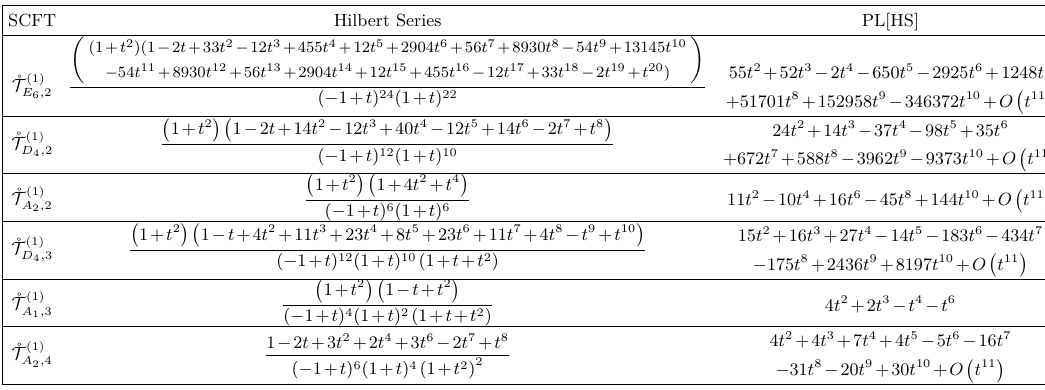
Table 13. Coulomb branch Hilbert series and plethystic logarithm for the magnetic quivers of ˚ T ( r =1) G,‘